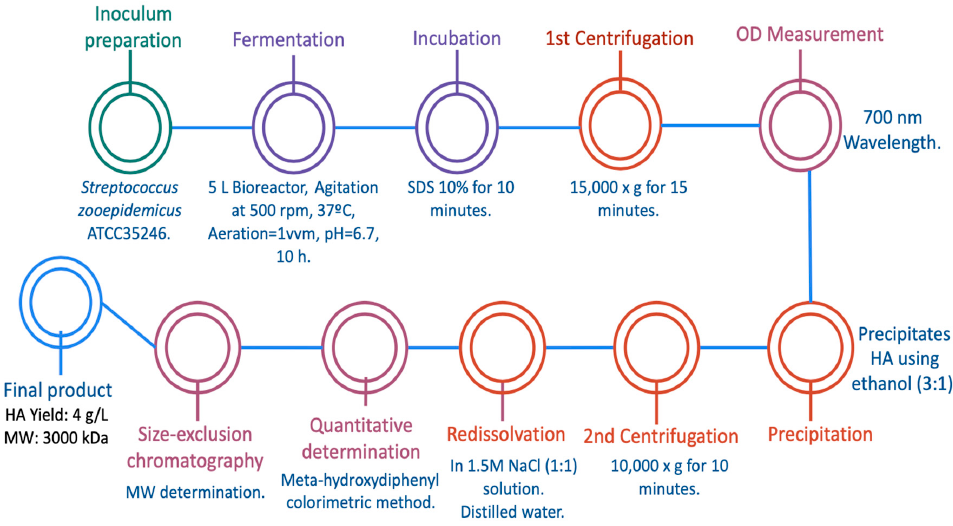
Figure 4. Hyaluronic acid production by Streptococcus equi subsp. zooepidemicus ATCC35246 in cheese-whey culture media [21].